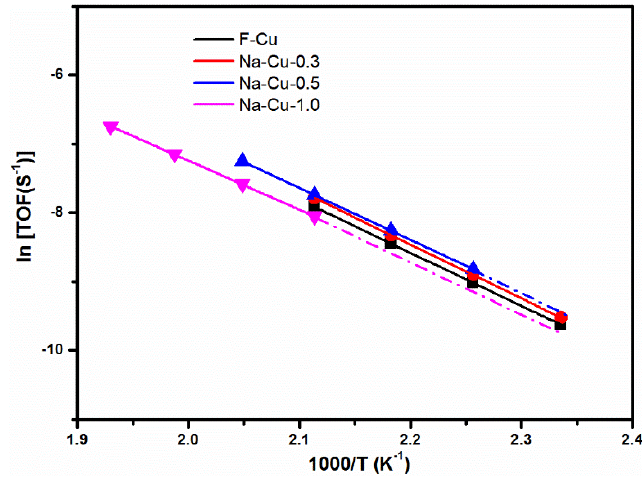
Figure 12. TOFs results of fresh and Na-impregnated catalysts.